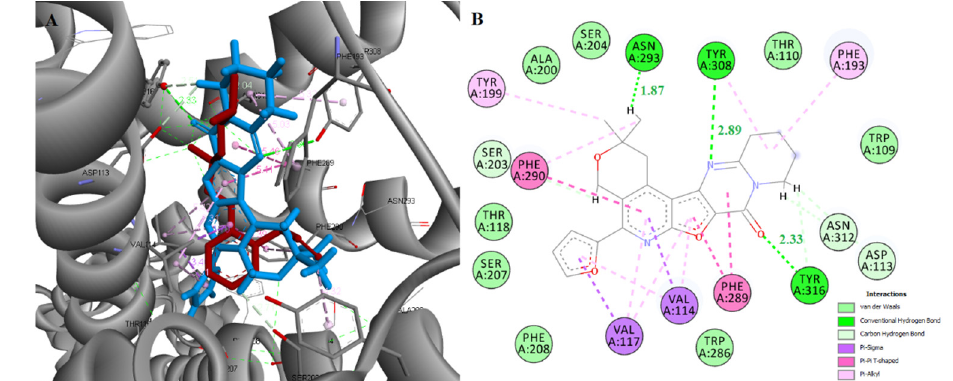
Figure 7. ( A ) Docked pose of compound 6n (blue) and alprenolol (red) into 5-HT 1A receptor ( B ) 2D ligand interaction diagram for docked compound 6n .